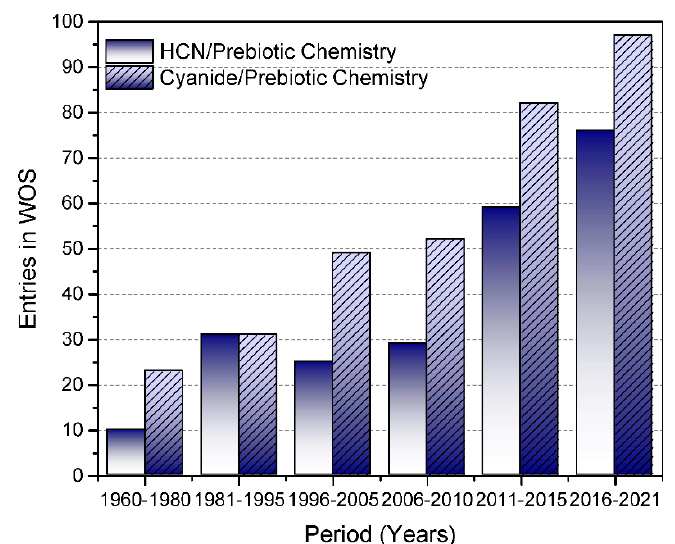
Figure 1. Number of entries provided by the Web of Science (WOS) database from 1960 to the present when performing a search with the keywords “HCN AND prebiotic chemistry” or “cyanide AND prebiotic chemistry”. In the first case, there are a total of 229 entries, and there are 335 entries in the second case (as of 18 February 2021). This figure clearly shows the growing interest in cyanide chemistry in studies about the origin of life over the years.